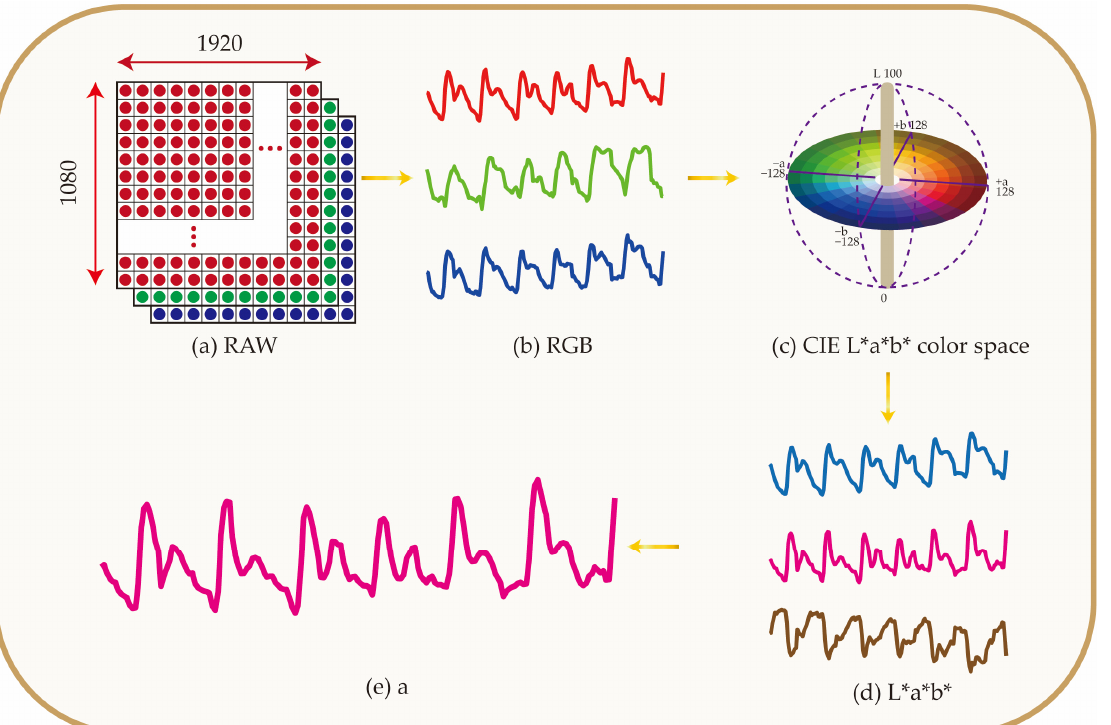
Figure 4. Smartphone collects the RGB channel information of the original image, converts it into the L*a*b* channel, and extracts the information of channel a for PPG calculations. ( a ) Schematic of a frame of image. ( b ) PPG signals of red, green, and blue channels. ( c ) CIE L*a*b* color space. ( d ) PPG signal of L*a*b* channels. ( e ) PPG signal of channel a.